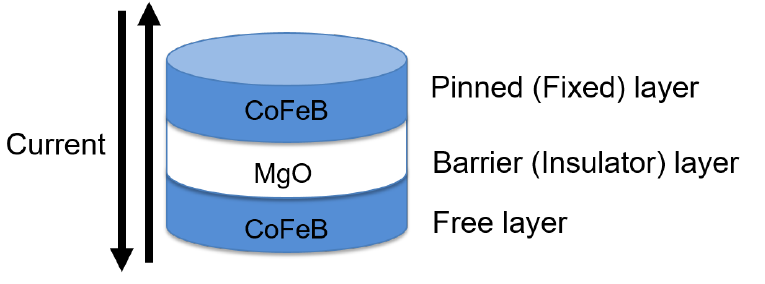
Figure 7. Block diagram of a perpendicular